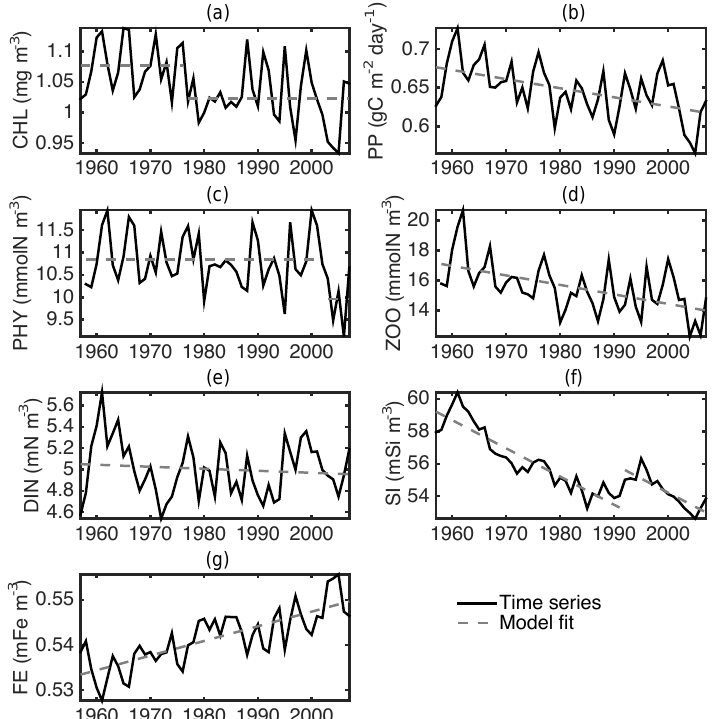
Figure B5. Time series of (a) surface chlorophyll, (b) integrated primary production, (c) total surface phytoplankton, (d) zooplankton biomass and (e) surface dissolved inorganic nitrogen, (f) silica and (g) iron simulated with the ERSEM model and averaged over the Gulf of Alaska region. The dotted lines represent the statistical model